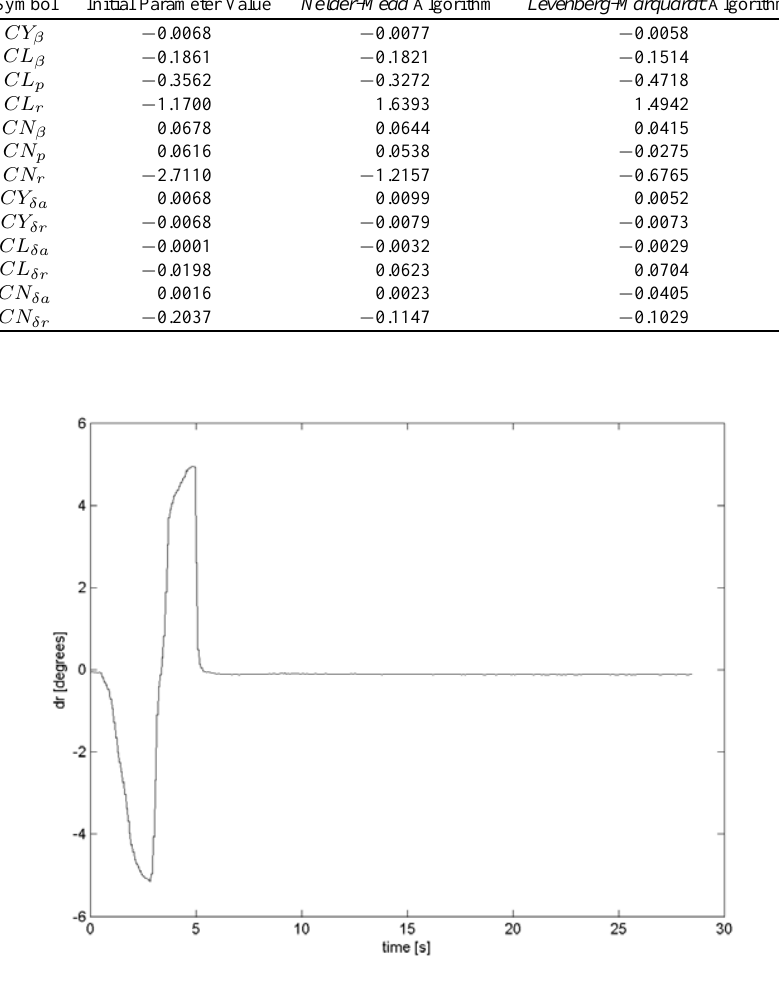
Fig. 7. Rudder deflections for the Dutch-roll